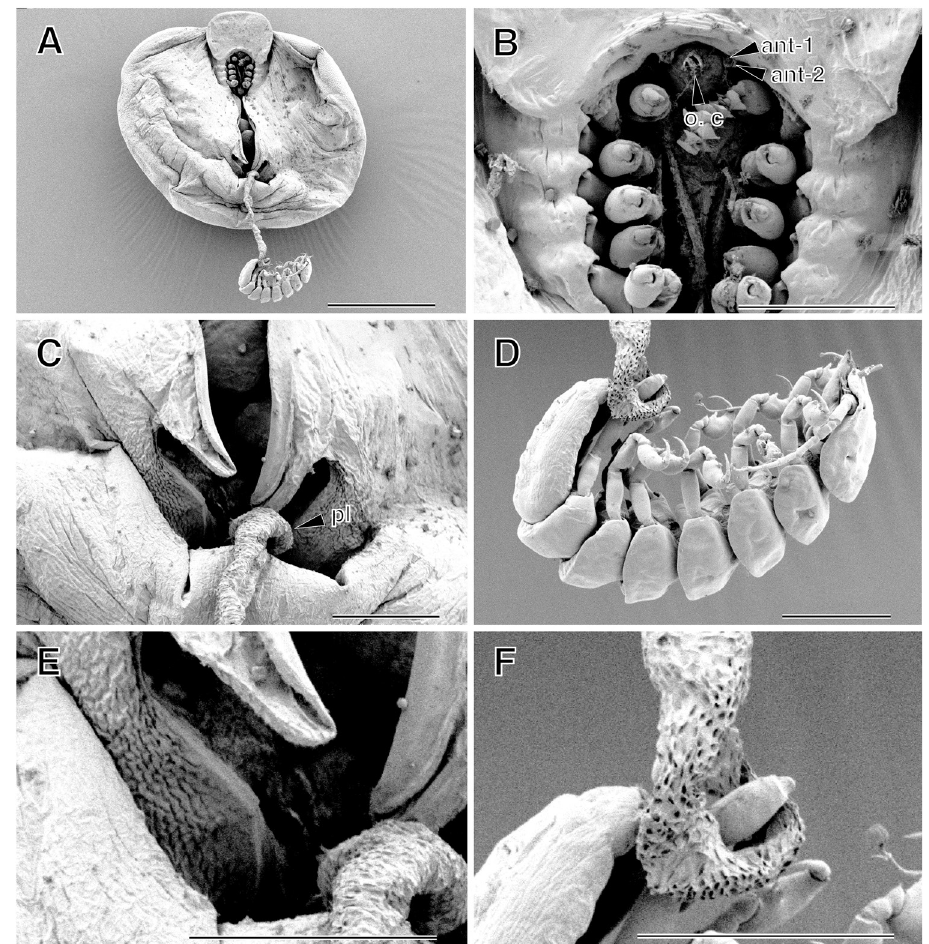
Figure 5. Aspidophryxus izuensis sp. n., A paratype female (KMNH IvR 500909) and male (KMNH IvR 500912) B, C, E, F paratype female (KMNH IvR 500909) D paratype male (KMNH IvR 500912). A habitus, female, ventral, male, dorsal; B cephalon and pereopods, ventral C pleon and digitate exten- sions of oostegites, ventral D habitus (clinging to female pleon by seventh pereopods), lateral E pleon and digitate extensions of oostegites, ventral; F female pleon, ventral. Scale bars A , 500 µm; B–D , 100 µm. Abbreviations: ant-1, antennule; ant-2, antenna; o. c, oral cone; pl,